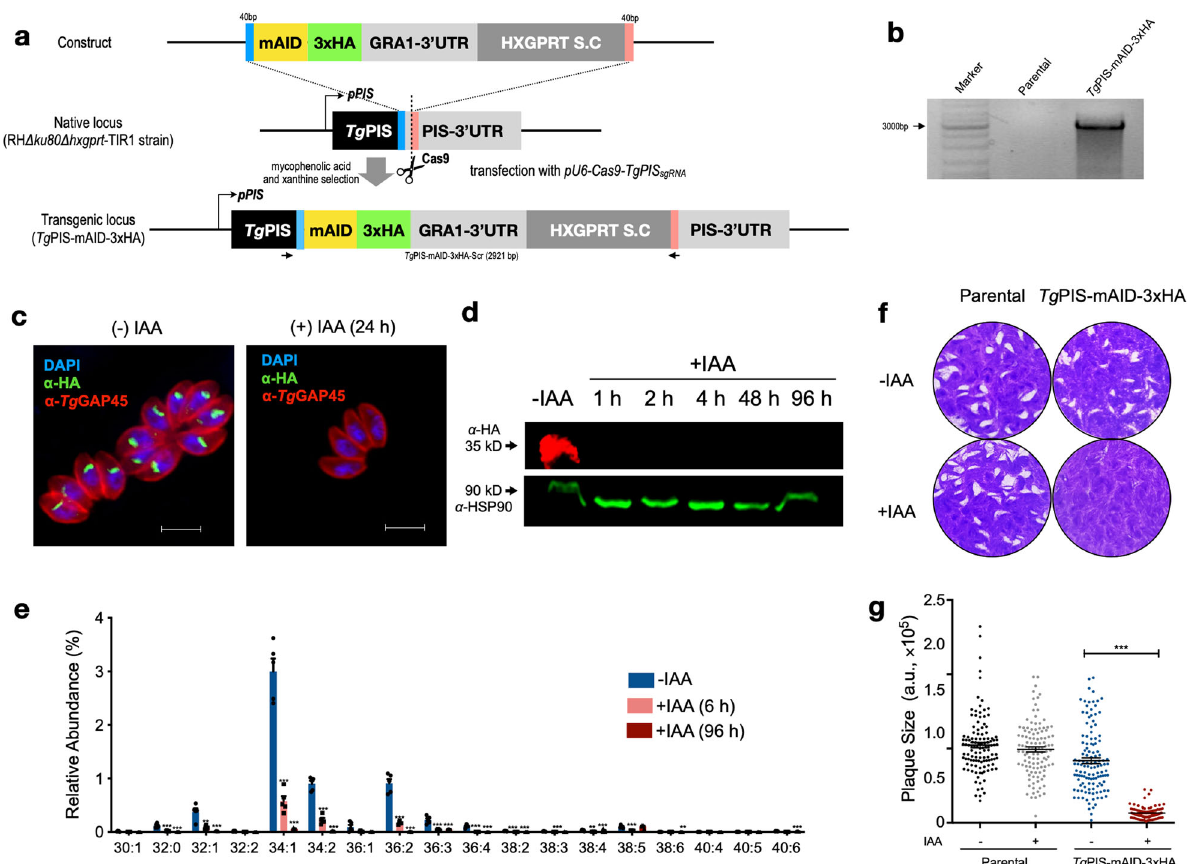
Fig. 4 Auxin-induced ablation of PtdIns synthesis blights the lytic cycle of tachyzoites. a Scheme showing the Cas9-assisted 3 ′ -genomic tagging of Tg PIS with a minimal auxin-inducible degron (mAID) and 3xHA epitope. Indicated amplicon (mAID-3xHA-GRA1 – 3 ′ UTR-HXGPRT) fl anked with short (40 bp) homology arms was co-transfected with the pU6-Cas9-TgPIS sgRNA vector (expressing Cas9 and single guide RNA) into the RH Δ ku80 Δ hxgprt - TIR1 strain, which was then drug-selected for the HXGPRT selection cassette (S.C.). The ensuing Tg PIS-mAID-3xHA strain expressed C-terminally epitope- tagged Tg PIS, and enabled its conditional knockdown by auxin treatment. b PCR con fi rming the event of 3 ′ -insertional tagging in the Tg PIS-mAID-3xHA strain. Primers used for the genomic screening at the TgPIS locus are marked as arrows in a . c Images showing a dependence of Tg PIS expression on auxin in the Tg PIS-mAID-3xHA mutant. Parasites were cultured with 500 µ M IAA for 24 h, and stained with α -HA and α - Tg GAP45 antibodies to visualize PIS (Golgi, green) and GAP45 (inner membrane complex, red). DAPI highlights the parasite and host-cell nuclei. d Immunoblot of the Tg PIS-mAID-3xHA strain treated with 500 μ M IAA for varying periods. The fusion protein was stained with α -HA antibody, and Tg HSP90 served as the loading control. e [ 13 C]- PtdIns synthesis in the extracellular tachyzoites of the Tg PIS-mAID-3xHA mutant cultured without or with auxin, as shown. Fresh tachyzoites (1 × 10 7 ) treated with 500 μ M IAA or carrier solvent (0.1% ethanol, -IAA) were labeled with 0.5 mM [ 13 C]- myo -inositol (6 h, 37 °C), followed by lipidomic analysis ( n = 5 assays). f , g Plaque assays revealing growth fi tness of the Tg PIS-mAID-3xHA mutant and parental strains. The crystal violet-stained images ( f ) reveal plaques formed by successive lytic cycles of tachyzoites in the absence or presence of IAA (500 μ M). The plaque area, depicted as arbitrary units (a. u.) in g , was measured by ImageJ. Over 100 plaques for each strain from 3 independent assays were scored. Data in e and g show the mean ± S.E (* p ≤ 0.05; ** p ≤ 0.01; *** p ≤